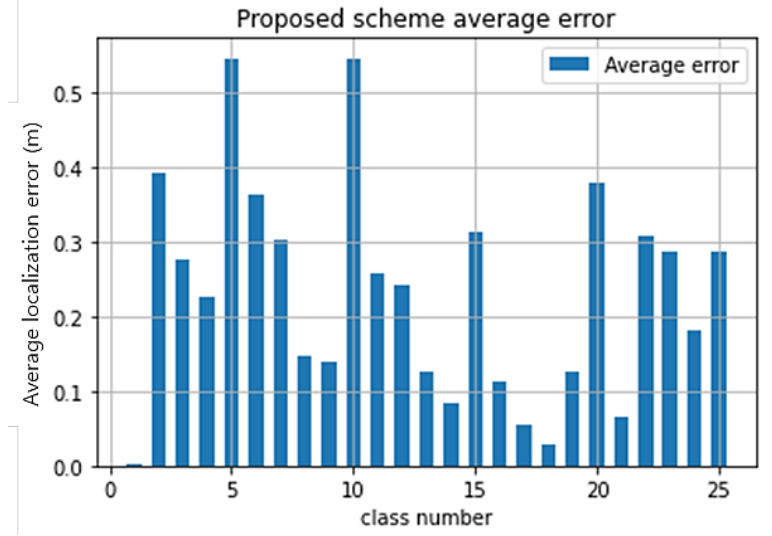
Figure 12. Localization error of the proposed CNN scheme.